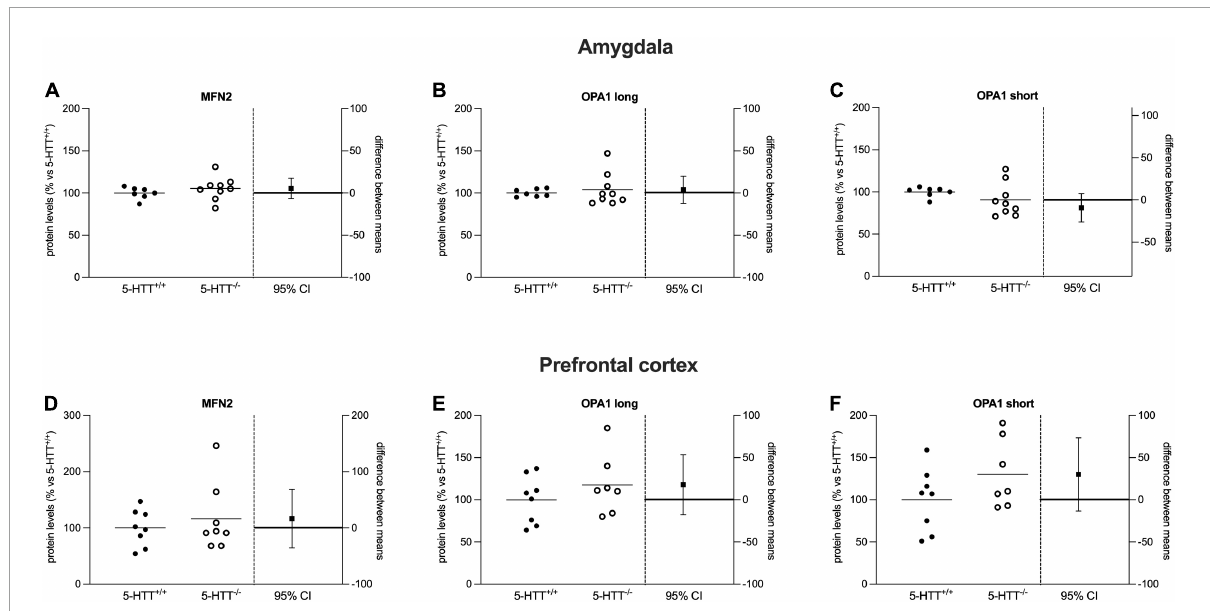
FIGURE4 Analysis of MFN2 and OPA1 (long and short) protein levels in the amygdala (A–C) and in the prefrontal cortex (D–F) of 5-HTT + / + and 5-HTT − / − rats. The results are represented as Gardner–Altman plots. The black square shows the difference between the two means, and the error bar shows the 95% confidence interval of that difference. The data are expressed as a percentage of 5-HTT + / + (set at 100%) of 6 to 10 independent determinations.